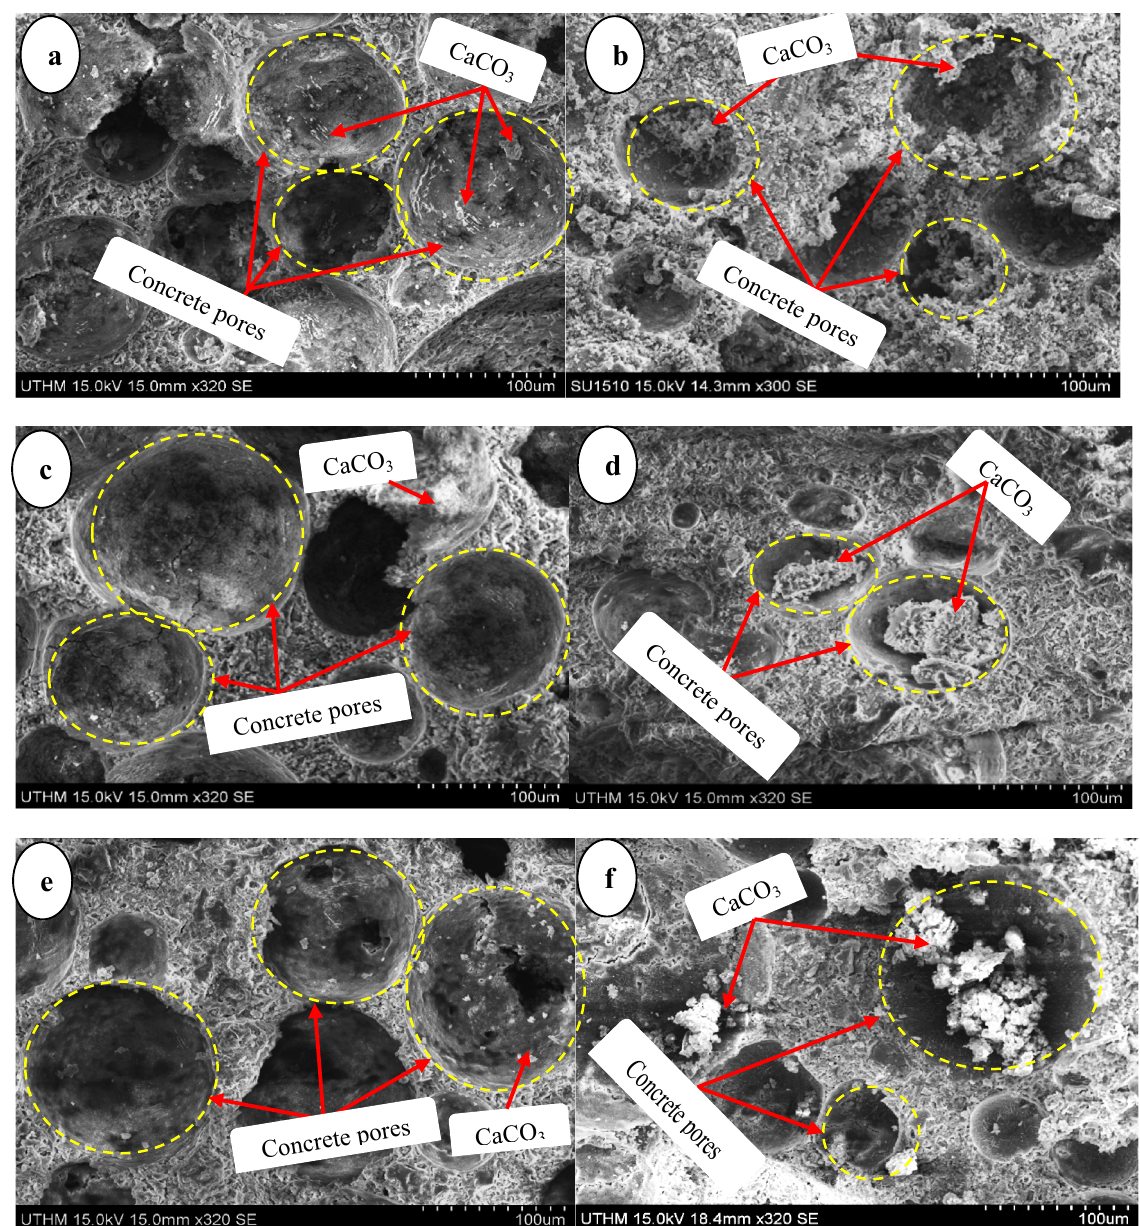
Figure 13. Comparison of SEM images between ( a ) FCB under 1300 kg/m 3 ( b ) B-FCB with 1300 kg/m 3 ( c